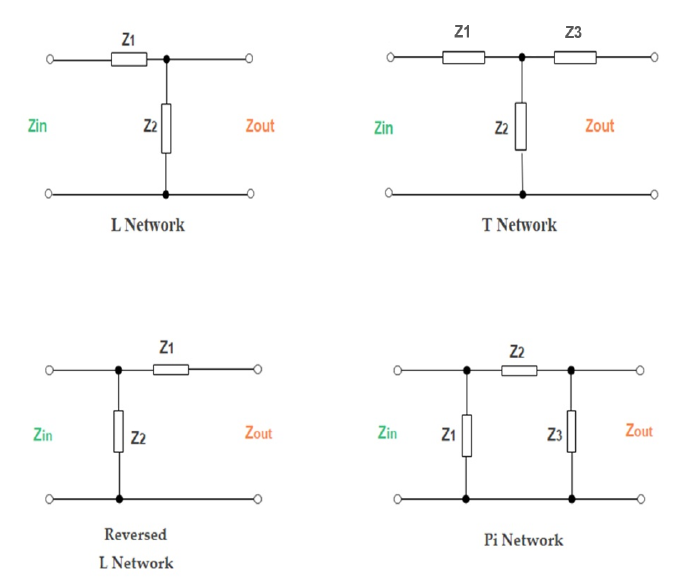
Figure 4. Different forms of common impedance matching